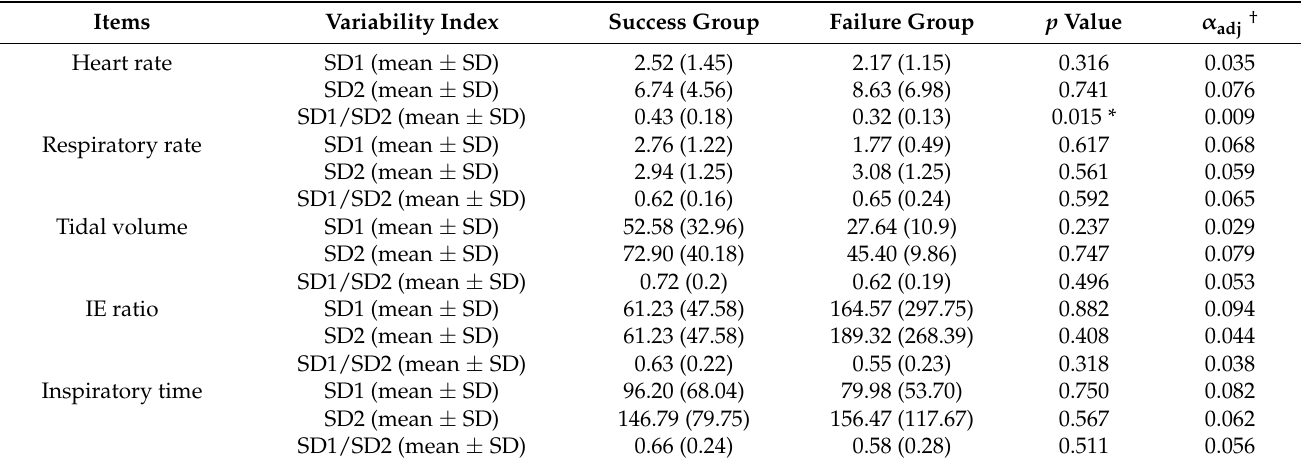
Table 2. Univariate analysis results of biosignal features between the weaning success and failure groups. Data are presented as mean ± standard deviation. IE ratio, inspiratory to expiratory time ratio; ABP, arterial blood pres- Data are presented as mean ± standard deviation. IE ratio, inspiratory to expiratory time ratio; ABP, arterial blood pres- sure; ECG, electrocardiogram; PPG, photoplethysmogram; SD1, standard deviations between short-term heart rate varia- sure; ECG, electrocardiogram; PPG, photoplethysmogram; SD1, standard deviations between short-term heart rate varia- Data are presented as mean ± standard deviation. IE ratio, inspiratory to expiratory time ratio; ABP, arterial blood pres- Data are presented as mean ± standard deviation. IE ratio, inspiratory to expiratory time ratio; ABP, arterial blood pres- Data are presented as mean ± standard deviation. IE ratio, inspiratory to expiratory time ratio; ABP, arterial blood pres- Items Variability bility; SD2, standard deviations between long-term heart rate variability; SampEn, sample entropy. † α adj is the adjusted bility; SD2, standard deviations between long-term heart rate variability; SampEn, sample entropy. † α adj is the adjusted sure; ECG, electrocardiogram; PPG, photoplethysmogram; SD1, standard deviations between short-term heart rate varia- sure; ECG, electrocardiogram; PPG, photoplethysmogram; SD1, standard deviations between short-term heart rate varia- sure; ECG, electrocardiogram; PPG, photoplethysmogram; SD1, standard deviations between short-term heart rate varia- statistically significant threshold α = 0.1 by multiple testing by Benjamini and Hochberg (BH) correction. ** Statistically statistically significant threshold α = 0.1 by multiple testing by Benjamini and Hochberg (BH) correction. ** Statistically bility; SD2, standard deviations between long-term heart rate variability; SampEn, sample entropy. † α adj is the adjusted bility; SD2, standard deviations between long-term heart rate variability; SampEn, sample entropy. † α adj is the adjusted bility; SD2, standard deviations between long-term heart rate variability; SampEn, sample entropy. † α adj is the adjusted significant variables after BH correction. * Statistically near significant variables after BH correction. significant variables after BH correction. * Statistically near significant variables after BH correction. statistically significant threshold α = 0.1 by multiple testing by Benjamini and Hochberg (BH) correction. ** Statistically statistically significant threshold α = 0.1 by multiple testing by Benjamini and Hochberg (BH) correction. ** Statistically statistically significant threshold α = 0.1 by multiple testing by Benjamini and Hochberg (BH) correction. ** Statistically significant variables after BH correction. * Statistically near significant variables after BH correction. significant variables after BH correction. * Statistically near significant variables after BH correction. significant variables after BH correction. * Statistically near significant variables after BH correction.